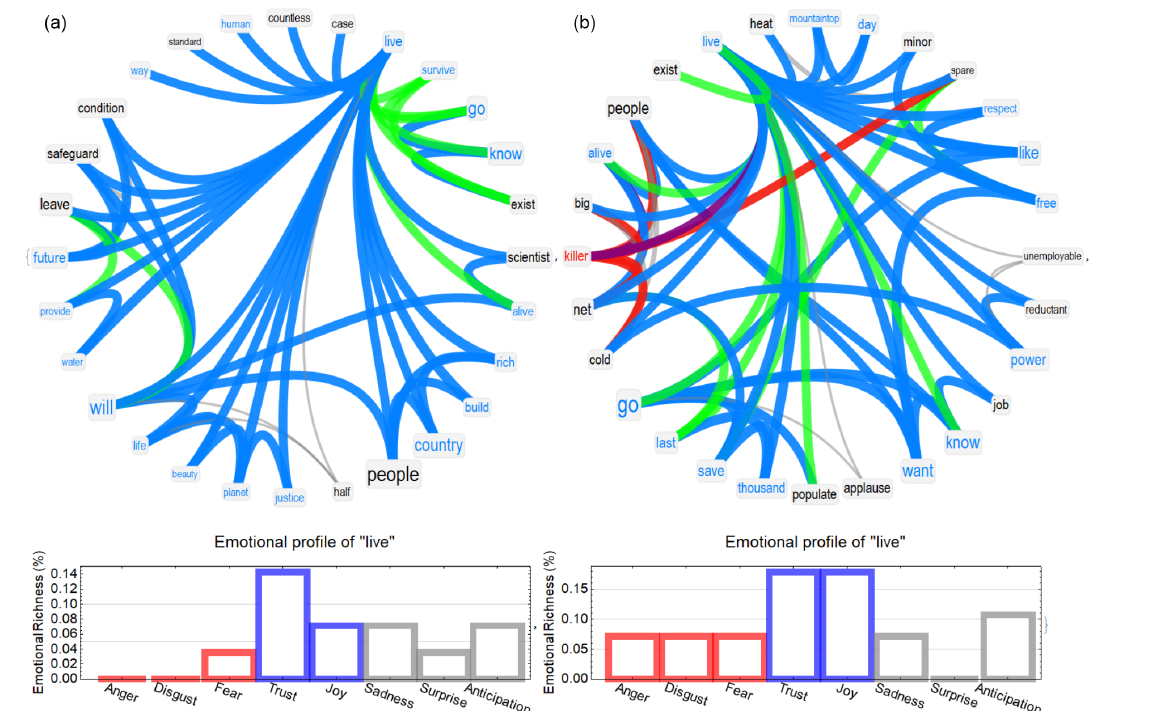
Figure 4. Speakers’ mindset reconstruction around “live” in the speeches of Greta Thunberg (a) and Christopher Monckton (b) . We refer the reader to Fig. 1 for a detailed explanation of the colour code and to Lexicon 1 for an interpretation of the